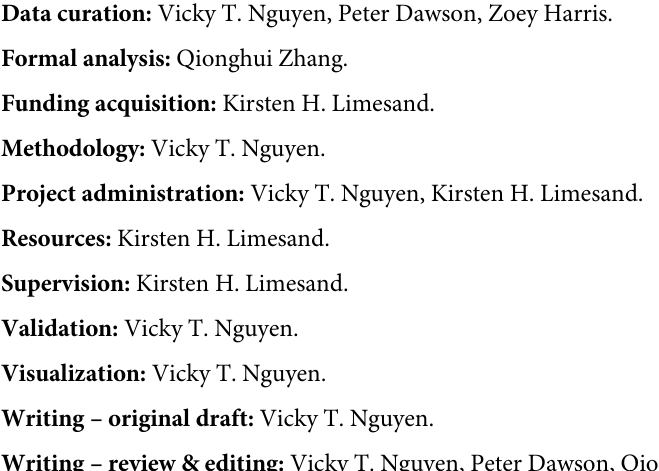
S6 Fig. Post-treatment of IGF1 increases sphere-forming efficiency of irradiated parotid- derived cells from adult salivary glands. A single 5 Gy dose of radiation was given to 8 week old FVB mice followed by injections of insulin growth factor 1 (IGF1) on days 31–33 as depicted in Fig 6A. Thirty days following IGF1 treatment, parotid glands were collected for sphere formation assay. Representative bright field images of salispheres grown from irradi- ated (IR d60) and IGF1 treated (IR-IGF1) glands in serum-free media at different time points in culture (A). Representative graph of the average number (± SEM) of salispheres from 10 wells per treatment group on day 7 in culture from one IR d60 and IR+IGF primary sphere preparation (B). Irradiated (IR d60) and IGF1 treated (IR-IGF1) parotid-derived salispheres were fixed after 7 days in culture and stained for Ki-67 (green). Representative confocal immu- nofluorescence images are shown (C). Scale bar = 50μm.